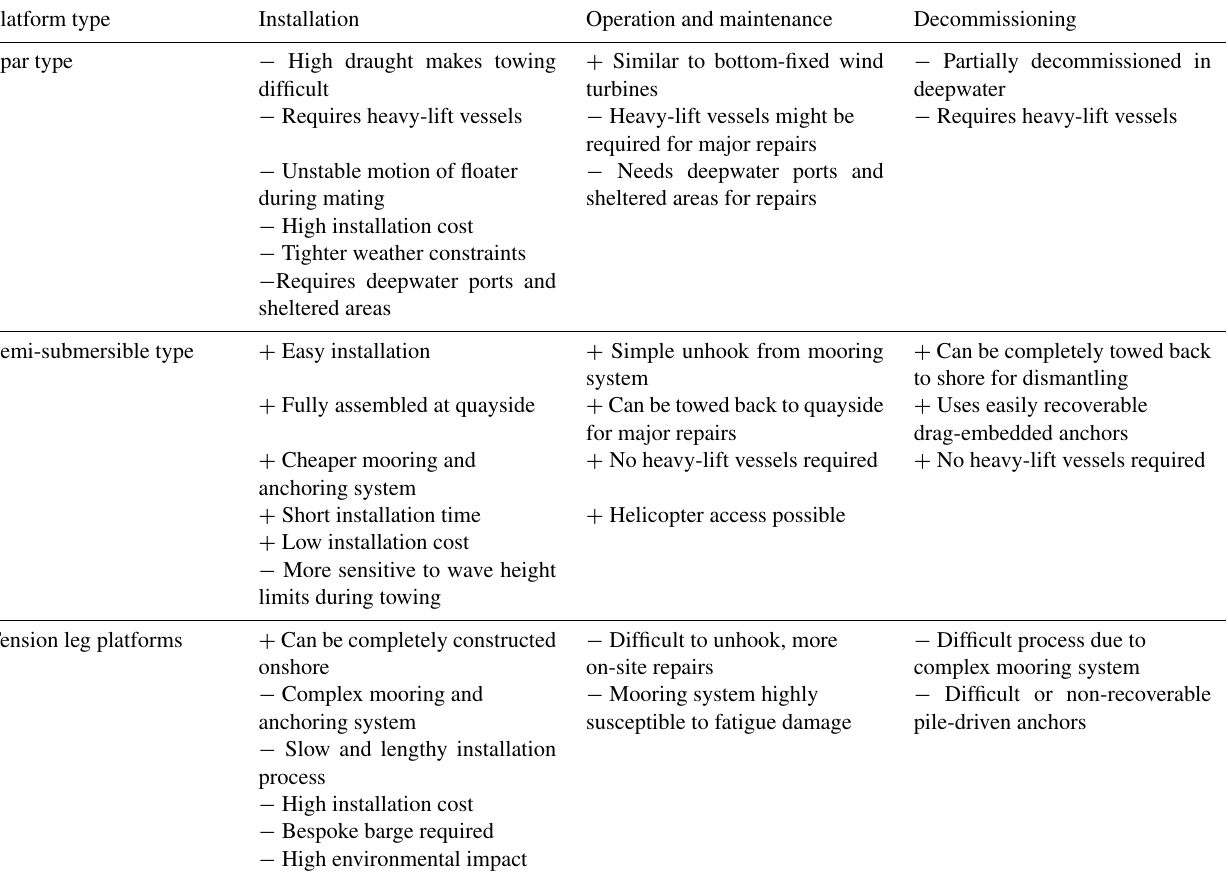
Table 1. Advantages and disadvantages concerning installation, O&M and decommissioning of different floater types of FOWTs (Leimeister et al., 2018; James and Ros, 2015; Liu et al., 2016).